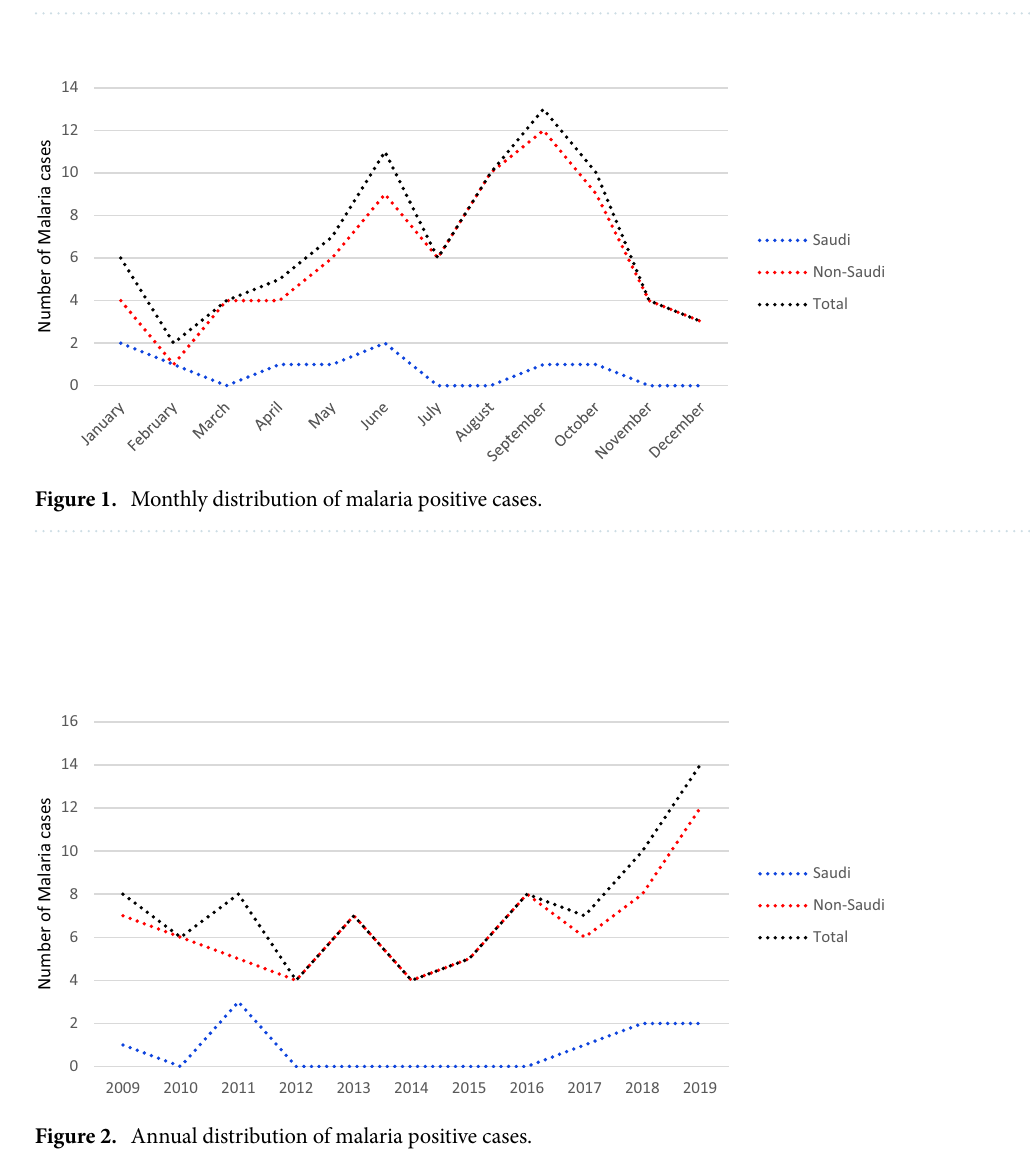
Table 2. Seasonality of febrile patients and its association with malaria infection. Proportions of categorical variables were compared using the Chi-square test. * P- value < 0.05 is significant.